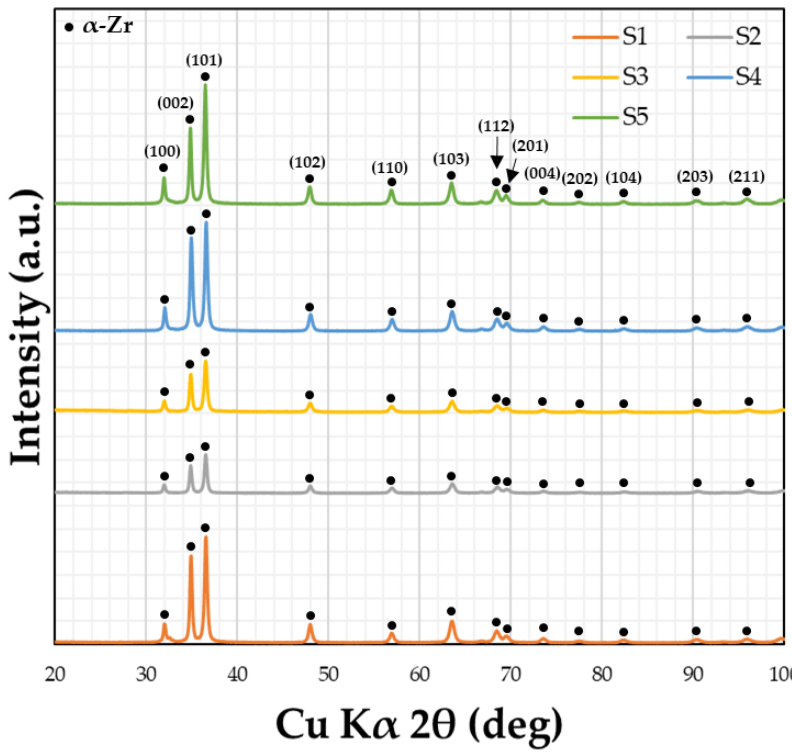
Figure 8. XRD patterns of the Zr CS coatings.